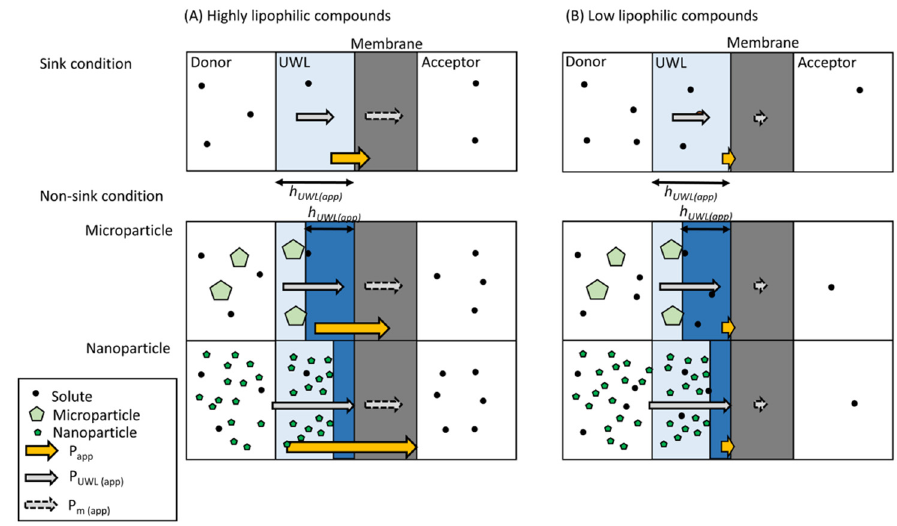
Figure 12. Proposed mechanism of permeability improvement by nanoparticle formulations.